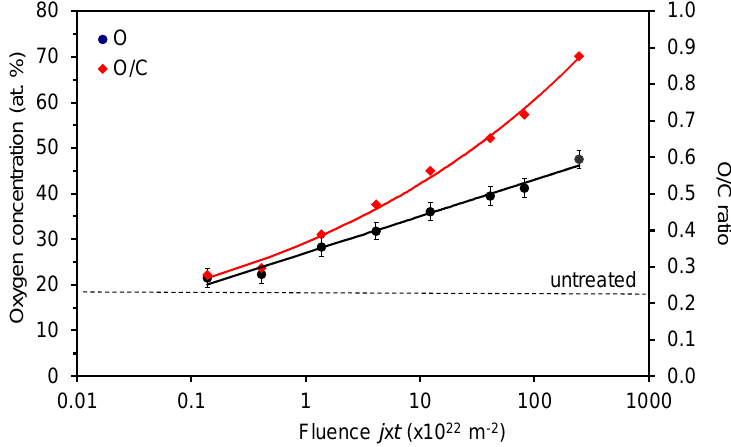
Figure 4. Variation of the oxygen concentration and the O/C ratio on the acryl-coated PP polymer surface with the O-atom fluence.